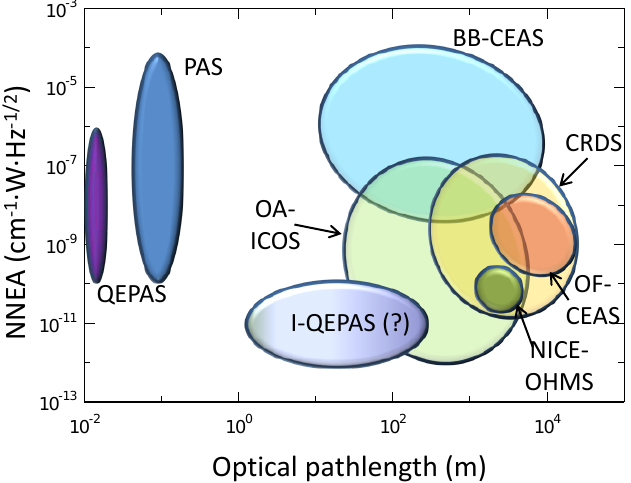
Figure 19. NNEA for categories of gas detection techniques as a function